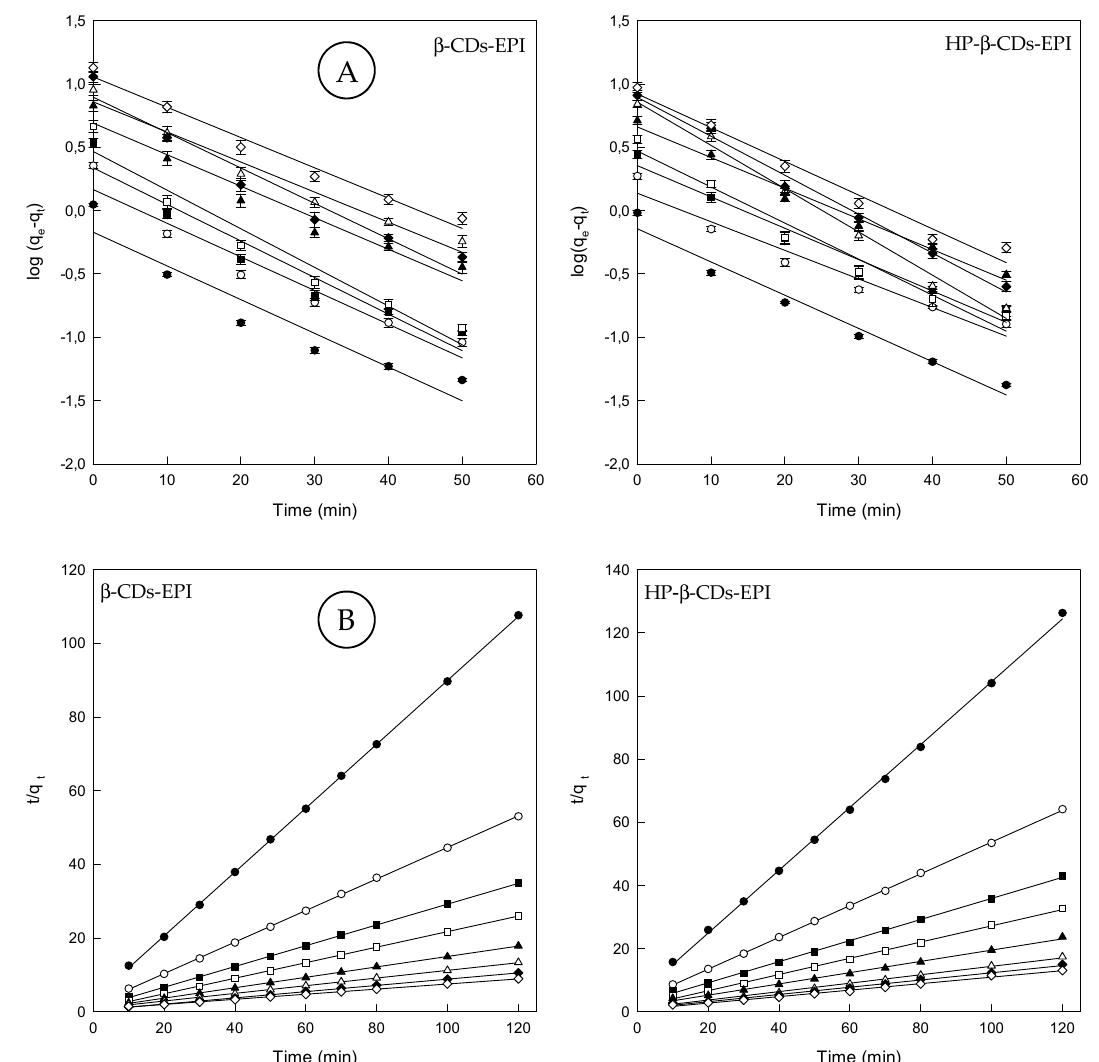
Figure 2. ( A ) Pseudo first order model plots and ( B ) pseudo second order model plots for the Direct Red 83:1 adsorption onto β -CDs-EPI and HP- β -CDs-EPI polymers at different dye concentrations (25 mg/L ( ● ), 50 mg/L ( ○ ), 75 mg/L ( ■ ), 100 mg/L ( □ ), 150 mg/L ( ▲ ), 200 mg/L ( Δ ), 250 mg/L ( ♦ ) and 300 mg/L ( ⟡ )).